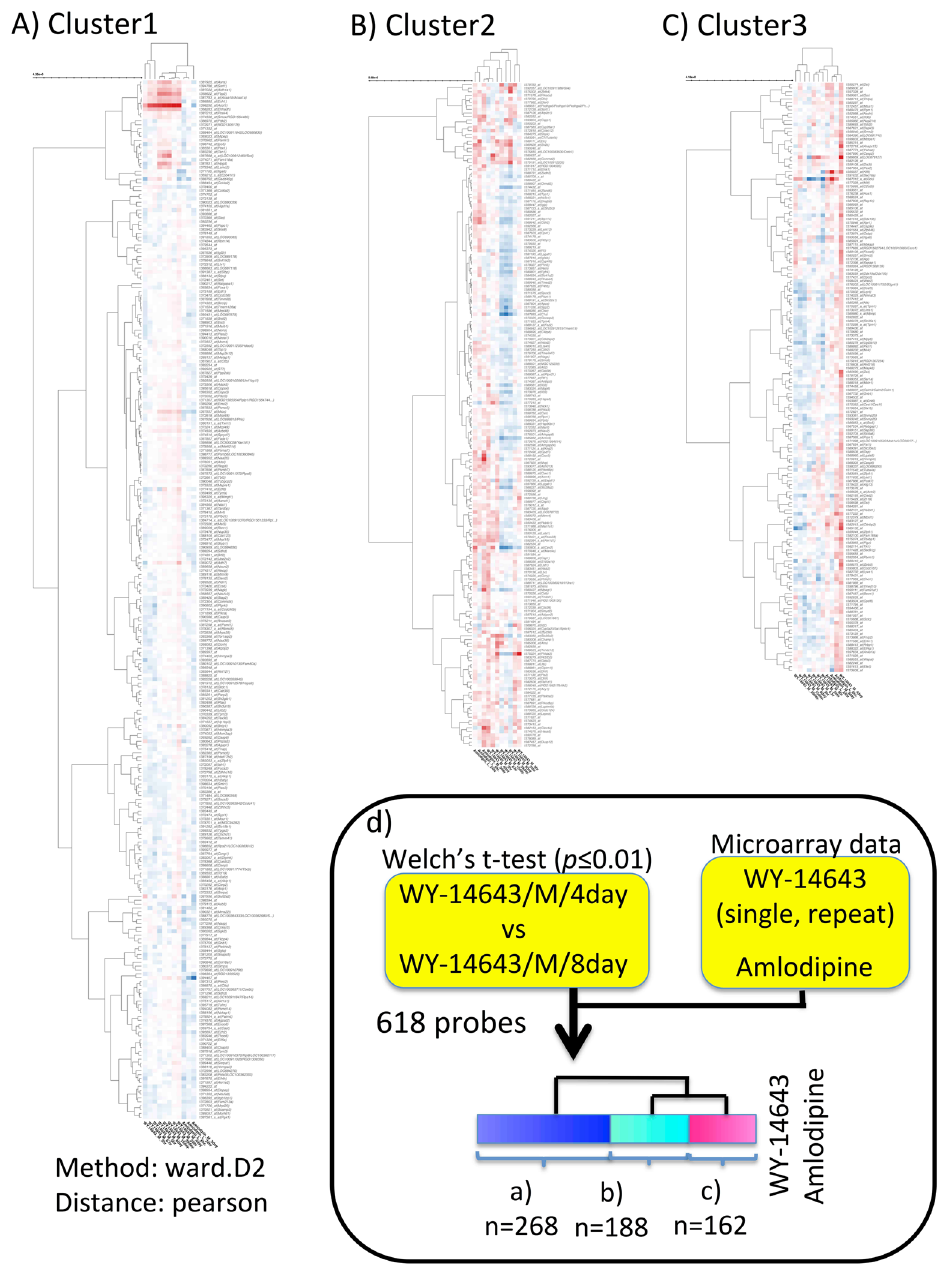
Figure 2. Heatmap of gene expression profiles obtained by treatment of WY-14643. The dendrogram was made without log-transformation of the axis, according to a hierarchical clustering result (method: ward. D2, distance: Pearson). ( A ) Gene expression profile of M4vs8_cluster1 (probe: n = 268). The x-axis represents experimental conditions (from left to right, (1–8) WY-14643 3 hr, 6 hr, 9 hr, 8 day, 15 day, 29 day, 24 hr and 4 day; (9–11) amlodipine 6 hr, 24 hr and 3 day. The y-axis represents probes in M4vs8_cluster1. ( B ) Gene expression profile of M4vs8_cluster2 (probe: n = 188). The x-axis represents experimental conditions (from left to right): (1–3) amlodipine 24 hr, 6 hr and 3 day; (4–11) WY-14643 4 day, 3 hr, 6 hr, 15 day, 29 day, 8 day, 24 hr and 9 hr. The y-axis represents probes in M4vs8_cluster2. ( C ) Gene expression profile of M4vs8_cluster3 (probe: n = 162). The x-axis represents experimental conditions (from left to right, 1–7) WY-14643 29 day, 15 day, 8 day, 3 hr, 6 hr, 24 hr and 9 hr; (8–10) amlodipine 24 hr, 3 day and 6 hr; 11) WY-14643 4 day). The y-axis represents probes in M4vs8_cluster3. ( D ) Analytical workflow for obtaining three M4vs8_clusters in (Fig. 2A–C). A gene set was selected by filtering DEGs between WY-14643/M dose/4 day and WY-14643/M dose/8 day by Welch ’s t-test (cutoff: p -value = 0.01). As columns, Open TG-GATEs samples of WY-14643 (single dose (30 mg/kg bw): 3 hr, 6 hr, 9 hr, 24 hr, repeat dose (30 mg/kg bw): 4 day, 8 day, 15 day, 29 day) and external samples of amlodipine (uploaded to Toxygates by “user data upload function”, L dose (0.2 mg/kg), 6 hr or 24 hr, and M dose (19 mg/ kg), 3 day) were used. The clusters were obtained by hierarchical clustering (dendrogram cutoff: 6). The high- resolution image file is available at Scientific Reports